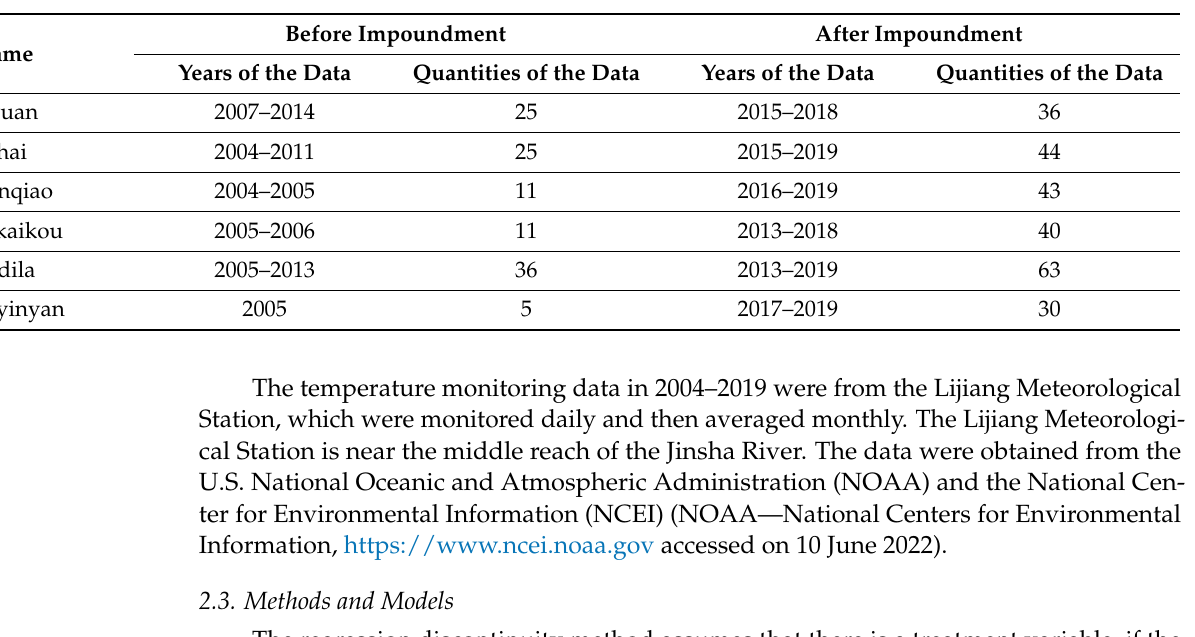
Table 2. Overview of water quality monitoring